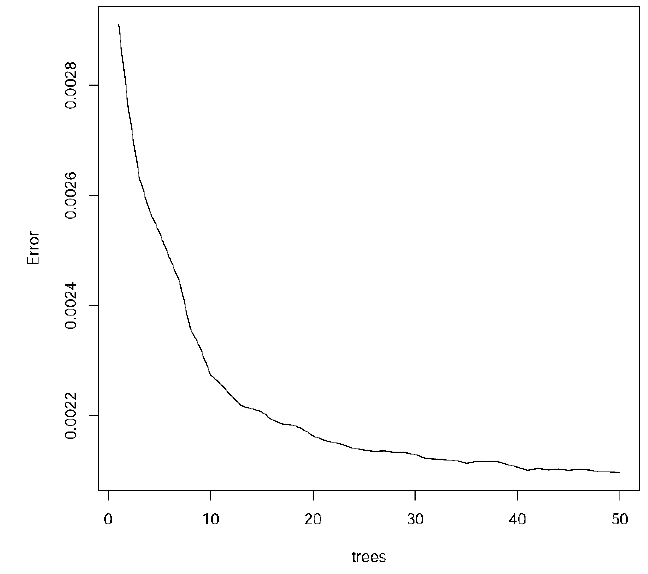
Figure 4. RF error with the number of trees for regression models.